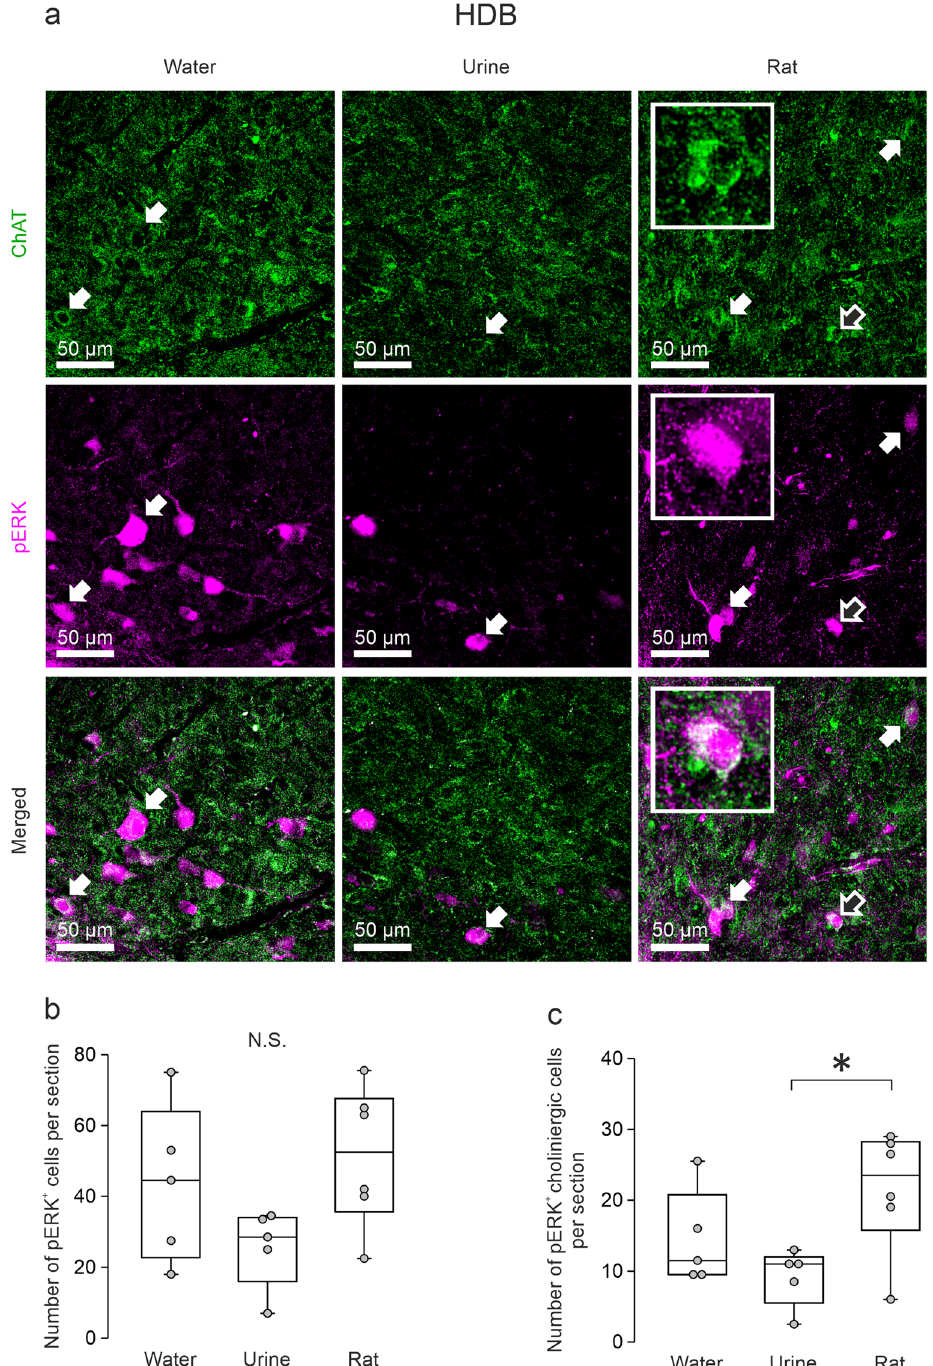
Fig. 5 Cholinergic cells in the horizontal limb of the diagonal band of Broca are activated during social interaction. a Representative average z- projections of the horizontal limb of the diagonal band of Broca (HDB) that were immune-stained for ChAT (choline-acetyltransferase, green, CF488) and pERK (magenta, CF 594) in the different experimental groups. Arrows indicate cells that are double-labeled for pERK and ChAT. Insets show enlarged pictures of the cell indicated by blank arrows. Scale bar, 50 µ m valid for all images in the same panel. b + c Averaged number of pERK + cells or pERK + cholinergic cells per section in different experimental groups. Data are presented as box-plots including fi rst, median, and third quartiles with whiskers representing the range of data points and distribution of single data points. One-way ANOVA, LSD for single comparisons, N.S., not signi fi cant, * p < 0.05 rat vs. urine, n = 5 rats (water), n = 5 rats (urine), n = 6 rats neurons in the rat exposure group was signi fi cantly higher than against pERK and choline acetyltransferase (ChAT, Fig. 5a). The that in the urine exposure group, even though the pERK + ACh total number of pERK + HDB cells was not signi fi cantly different between all groups (Fig. 5b; p = 0.104, ANOVA, water n = 5, neuron number in the rat exposure group was not higher than urine n = 5, rat n = 6) x . However, the number of pERK + ACh that in the water exposure group (Fig. 5c; p = 0.034, ANOVA, rat